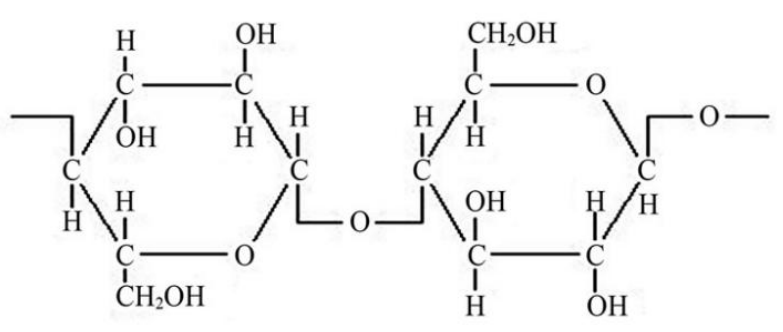
Figure 2. Structure of cellulose [13].